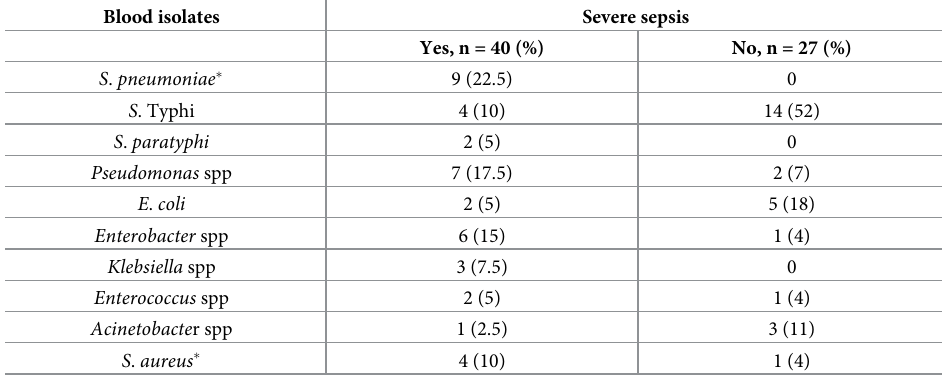
Table 3. Bacterial isolates from the blood of the study patients.